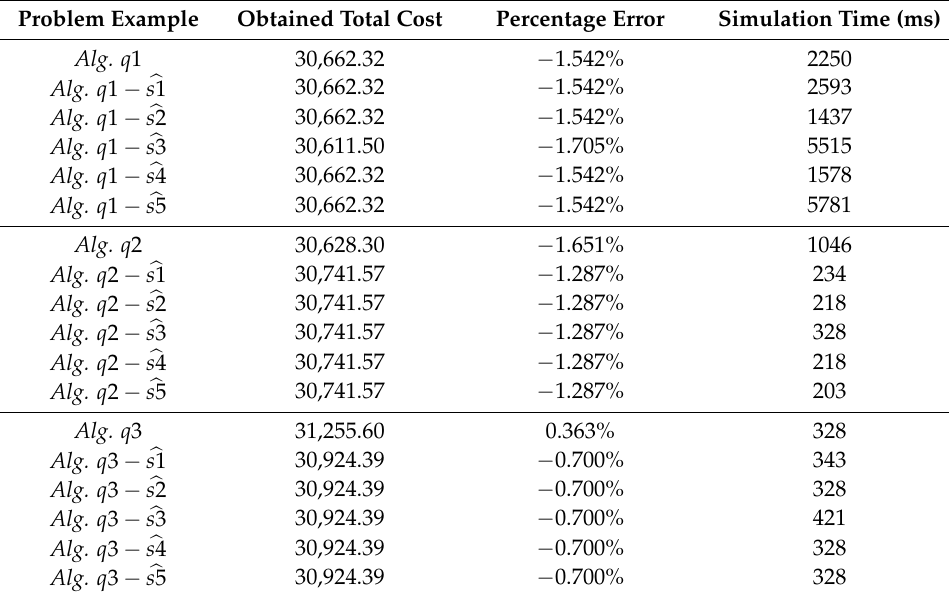
Table 11. Obtained results for irregular network GIr-4 (Suboptimal cost